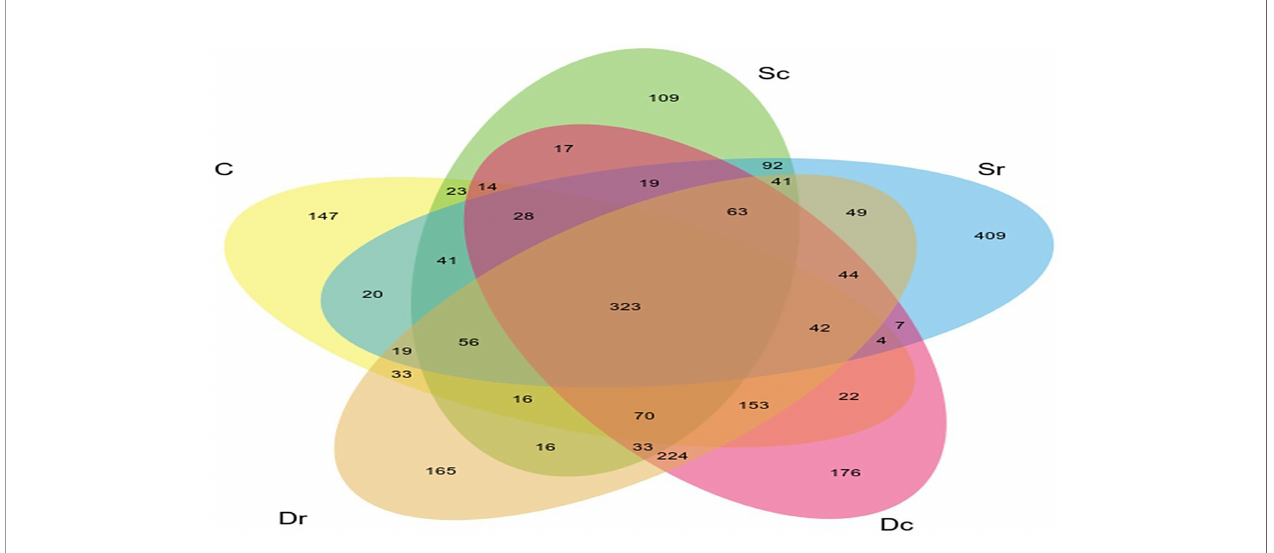
FIGURE 3 | Venn diagram of the relationships between soil samples (C, Dc, Dr, Sc, and